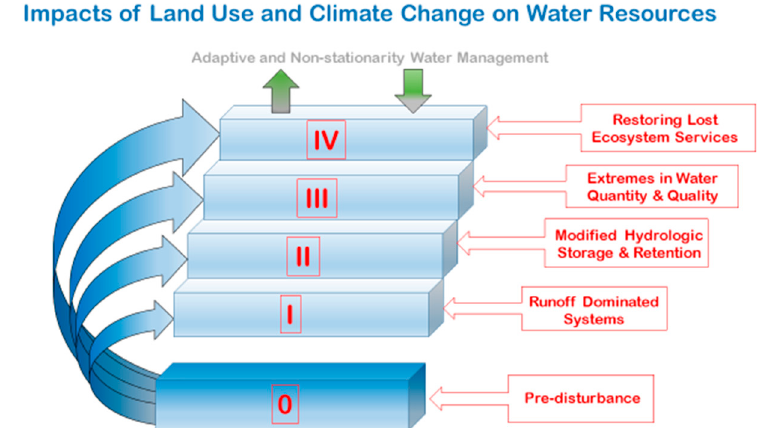
Figure 1. Conceptual model describing how land use and climate change alter the amount and quality of water across each step of human domination of Earth’s water cycle from degradation to ecosystem restoration.